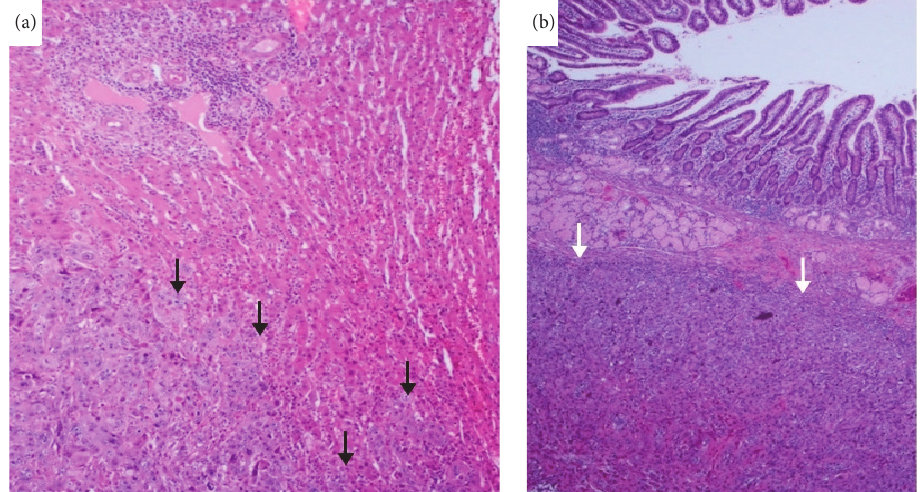
Figure 5: Local invasion of the tumor in liver parenchyma (black arrows) (a) and duodenum (white arrows)